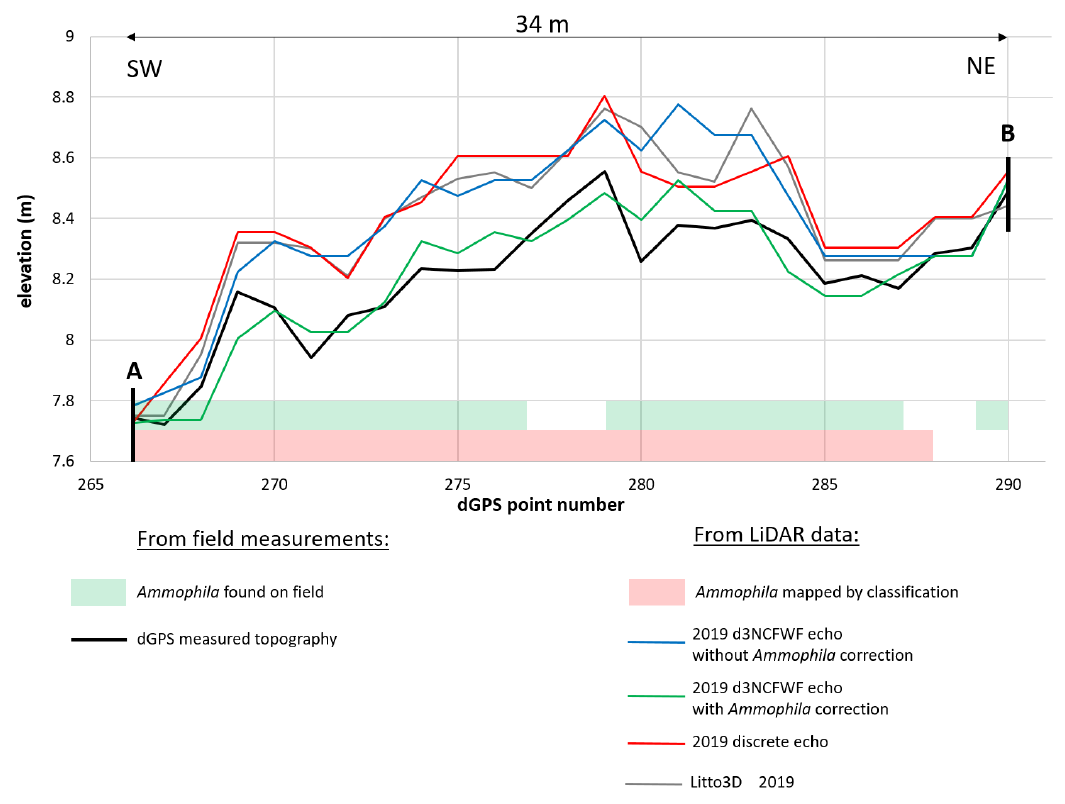
Figure 12. LiDAR elevation profiles of the fourth profile of Figure 11. The black line represents field dGPS, the red line is the 2019 discrete echo, the blue one is the 2019 FWF single echo without Ammophila arenaria correction, and the green one is the 2019 FWF single echo with Ammophila arenaria correction. The grey line represents IGN Litto3D